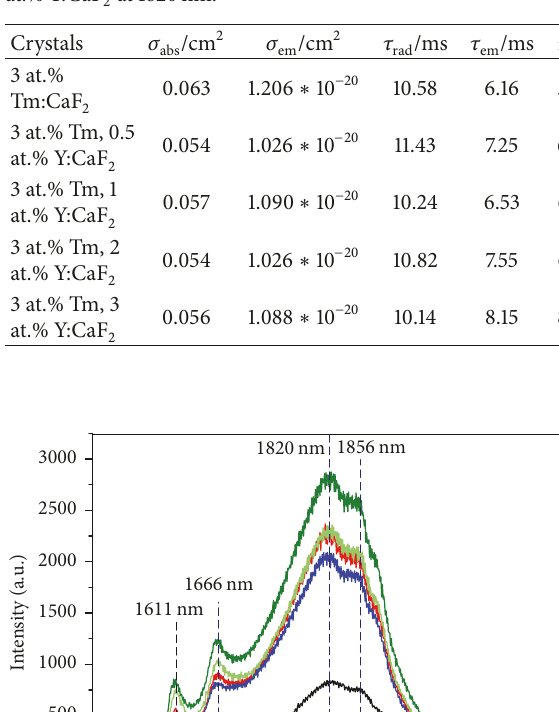
Table 1: The detailed values of 𝜎 abs , 𝜎 em , 𝜏 rad , 𝜏 em , 𝜂 of 3 at.% Tm, 𝑥 at.% Y:CaF 2 at 1820 nm.